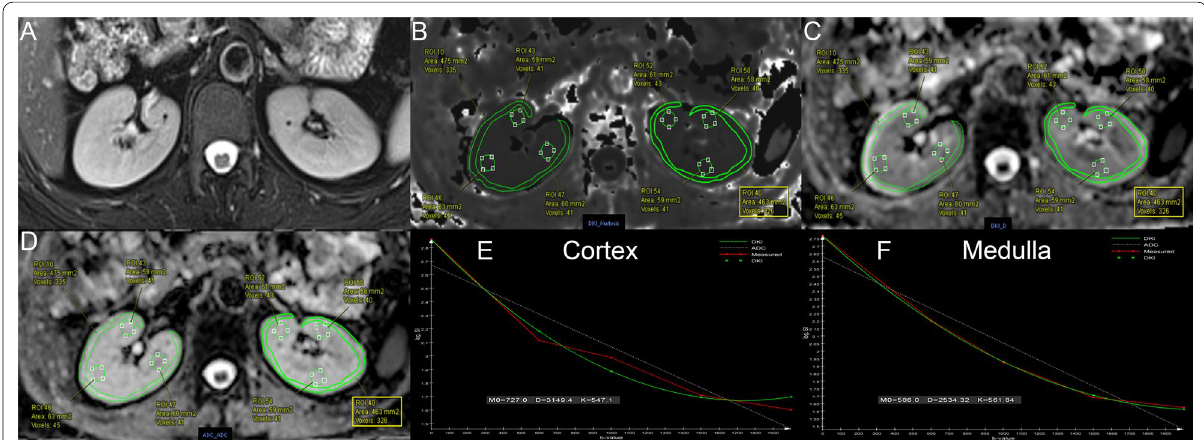
Fig. 2 Respective MRI images of healthy volunteers with eGFR medulla DKI fit,